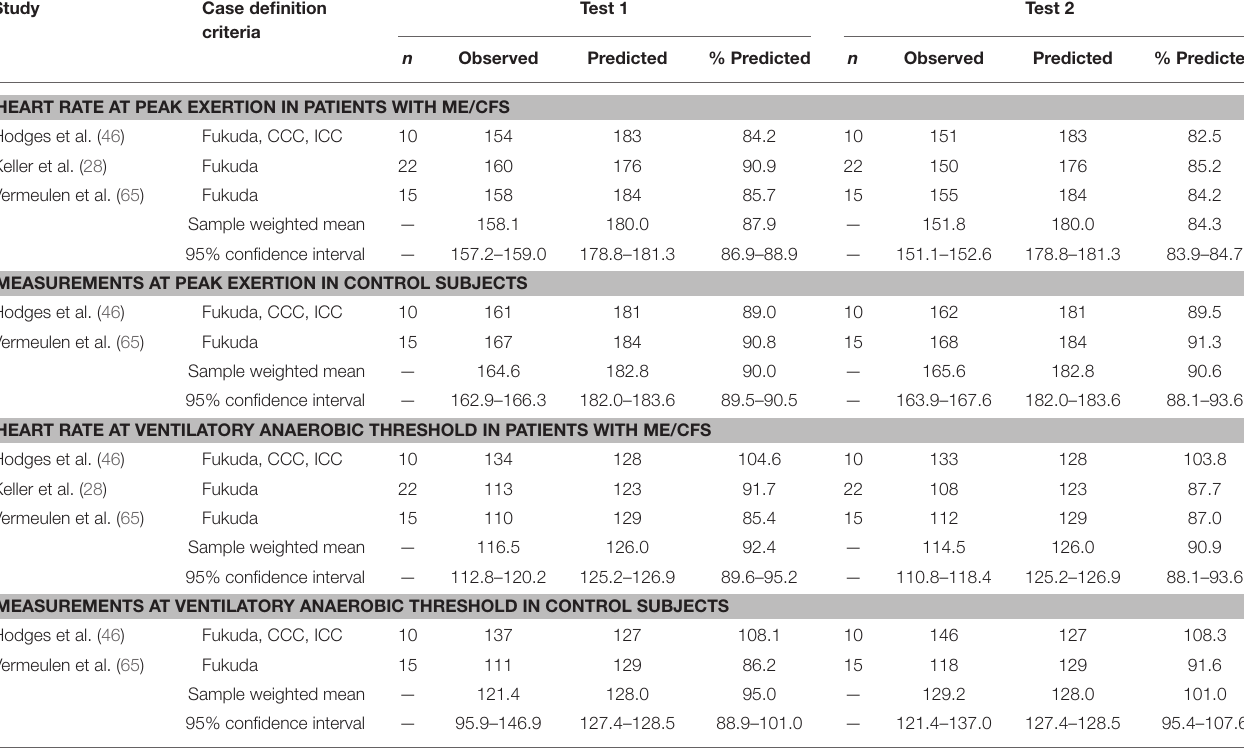
TABLE 4 | Heart rate measurements obtained at peak exertion and ventilatory anaerobic threshold during studies involving two cardiopulmonary exercise tests in individuals with myalgic encephalomyelitis/chronic fatigue syndrome ( n = 47) and matched control subjects ( n =